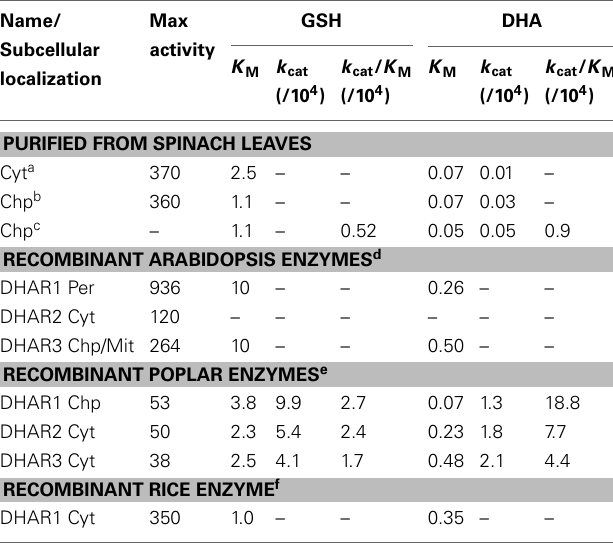
Table 2 | Kinetic properties of dehydroascorbate reductases from several plant species.